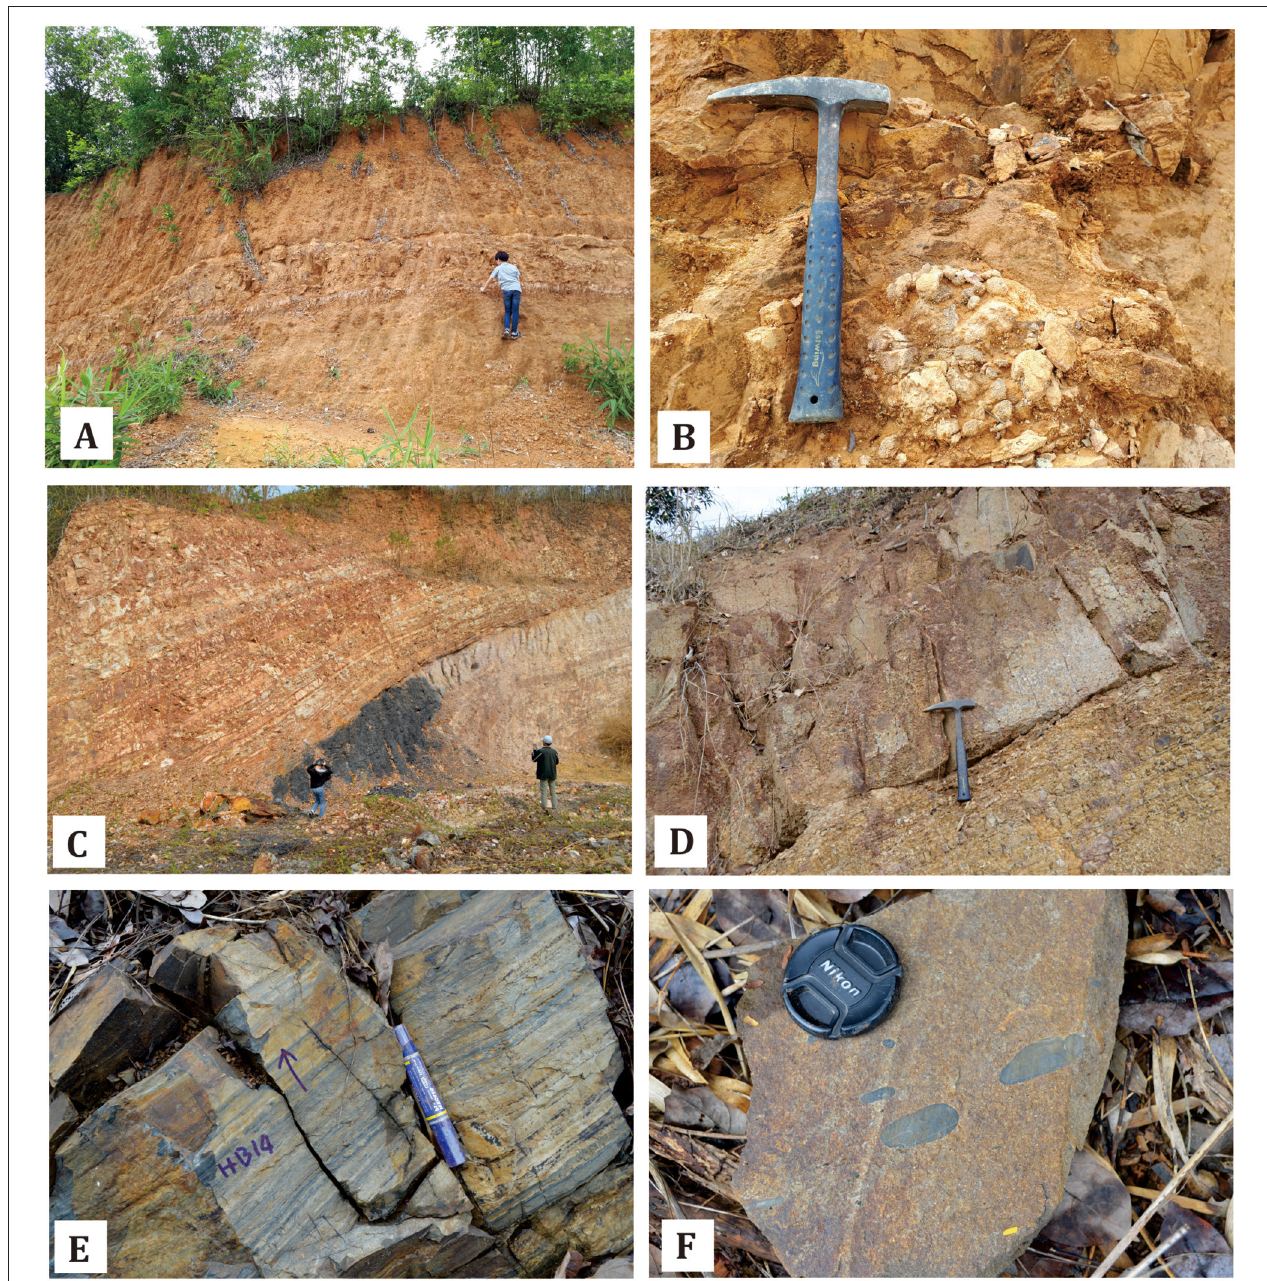
FIGURE 8 | Field photographs of significant Palaeozoic sequences in the Loei “Foldbelt” NE Thailand (LOEI on Figure 1 ). (A,B) are Silurian to Early Devonian volcaniclastics from east of the Loei Suture in the eastern part of the “Loei Foldbelt” belonging to the Truong Son Terrane as interpreted herein. This sequence is associated with marly mudstone and thin limestones with prolific corals and stromatoporoids. (C–F) are early Carboniferous siliciclastics in the Loei Foldbelt resulting from the proposed collision of the Truong Son and Loei-Phetchabun terranes. (A,B) Late Silurian to Early Devonian siliciclastic sequence from Ban Na Gniew in the east of Pak Chom in the Truong Son Terrane east of the Loei Suture (Loei Fault). This siliciclastic-volcaniclastic succession contains lighter colored limestone hardgrounds with a coral (e.g., Heliolites , Favosites ), brachiopod, and trilobite fauna which interdigitate with a late Silurian to Early Devonian volcanic arc toward the west. (B) Close-up of A showing large domal tabulate coral. Brachiopods, trilobites, and other benthic faunas are common in this succession. (C) Carboniferous siliciclastic sequence with anthracitic coal from west of Pak Chom of possible late Visean age as a consequence of collision and uplift. (D) Channel conglomerate overlying thin-bedded shale and sandstone (greywacke) of proximal to distal submarine fan lobe. This sequence indicates the beginning of early Carboniferous (late Tournaisian to early Visean) collision in the region. (E) Siliceous shale showing lamination with flame structure indicative of a turbiditic event deposited between a distal fan lobe and basin and the result of the postulated Tournaisian - early Visean terrane collision. (F) Conglomerate showing rounded pebble clasts in the channel truncating the submarine fan. This unit is observed in association with a fine turbidite succession of late Tournaisian to early Visean age.